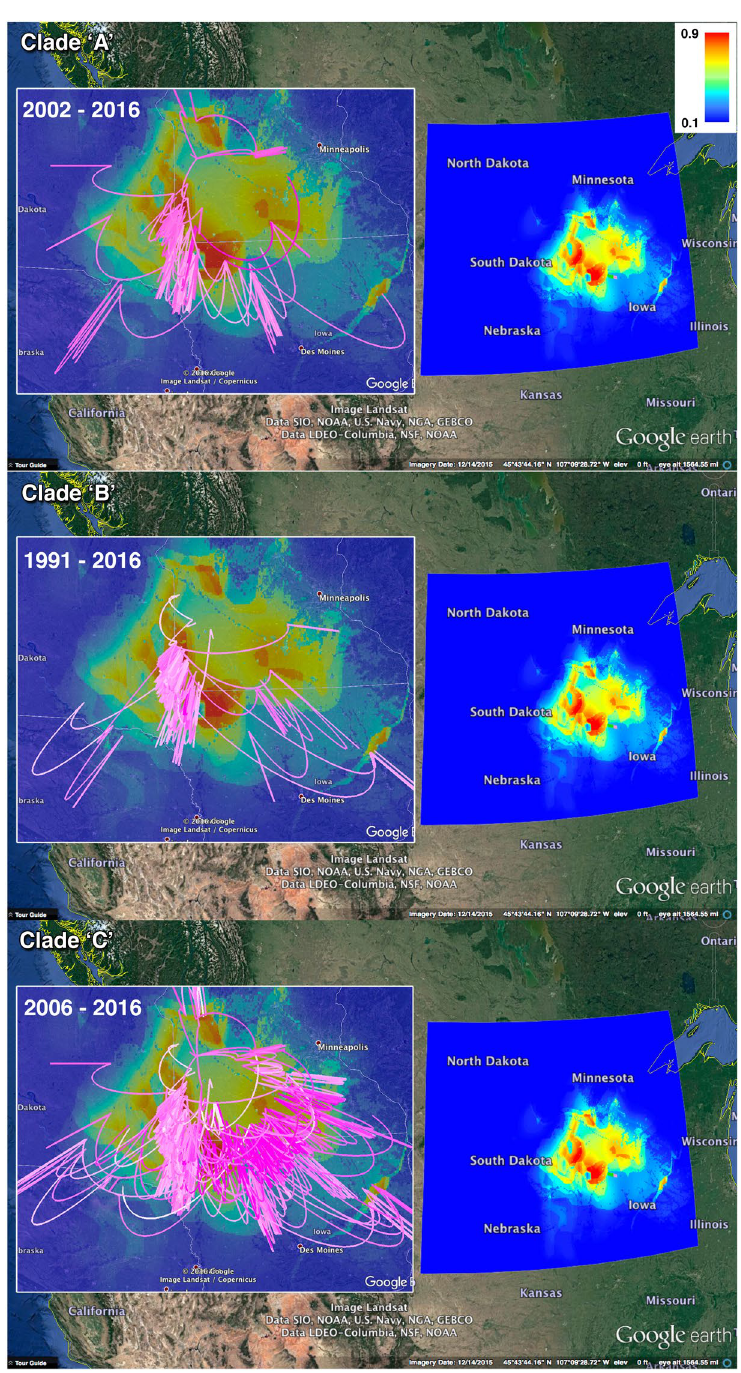
Figure 5. Clades’ ‘A’, ‘B’ and ‘C’ MCC tree spread and ecology in the Midwest. The Google Earth Pro snapshots of Clades MCC trees are superimposed on the predicted spatial risk of PRRSV outbreaks by the final Maxent model. The gradient color legend on the upper right represents the scale of the spatial probability distribution. The lines represent the continuous diffusion phylogeographic history of clade viruses, and their gradient colors represent their age (light pink = older, dark pink = younger). The figure is composed of satellite images captured as snapshots from Google Earth Pro (https://www.google.com/earth/). Figure’s associated three-dimensional movies corresponding to each clade are provided in the supplementary materials (File